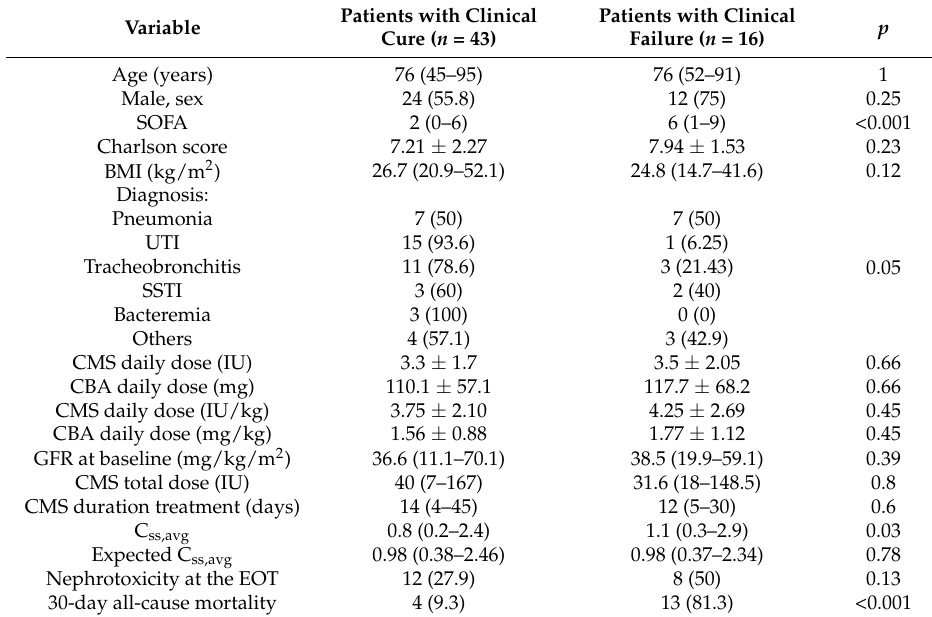
Table 3. Univariate analysis of patients with and without clinical cure.